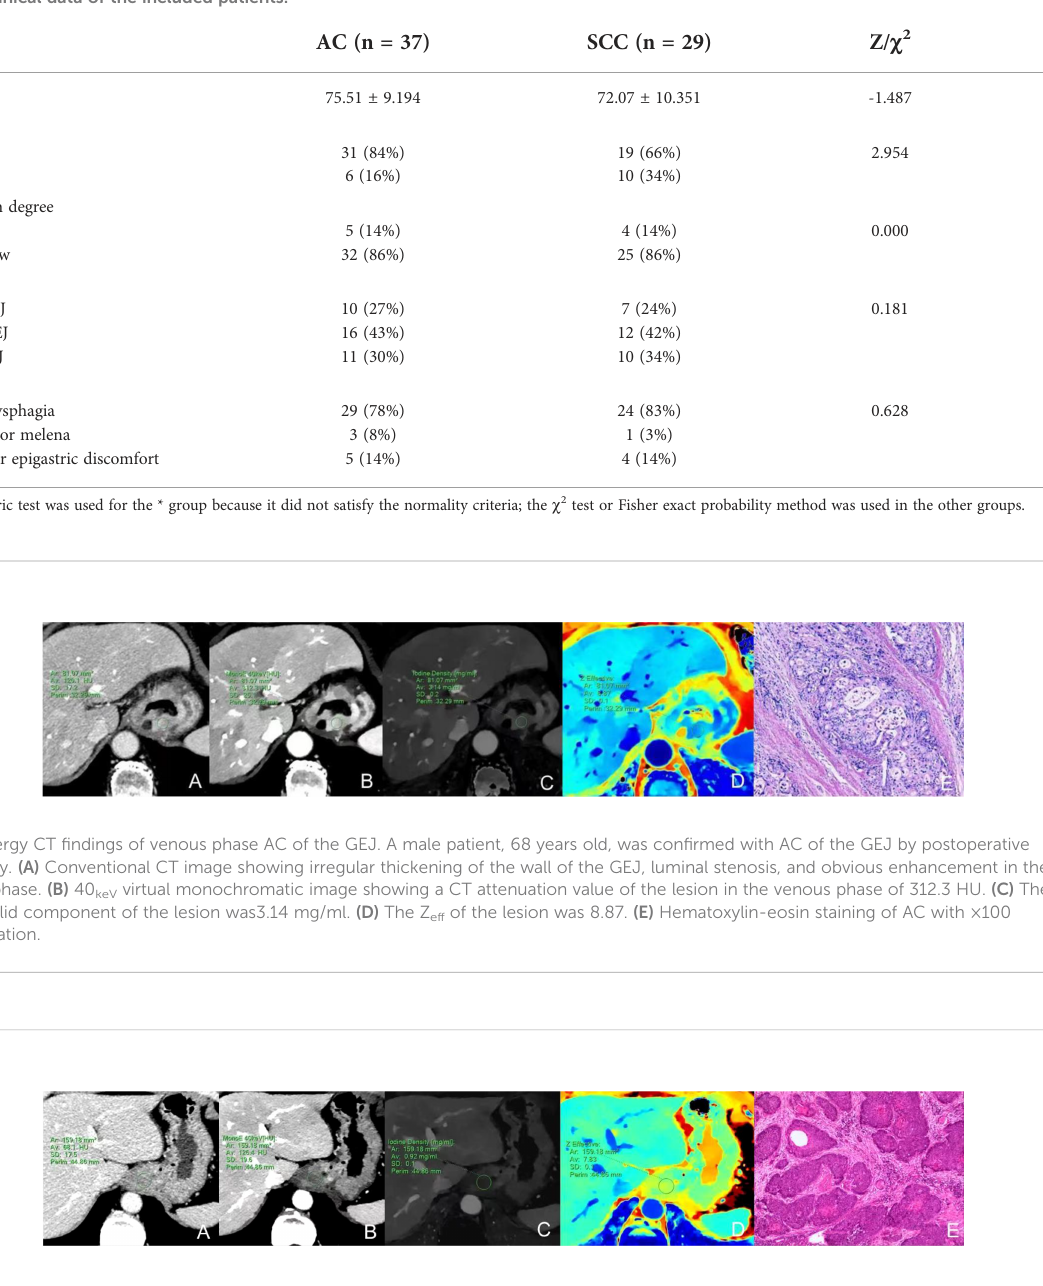
(Figure 4). Detailed results of ROC analysis were listed in Table 3. Delong test showed that the AUC of △ CT VP was signi fi cantly lower than that of combination (IC VP , l HU VP , CT 40keV VP and Z eff VP ), P<0.05.